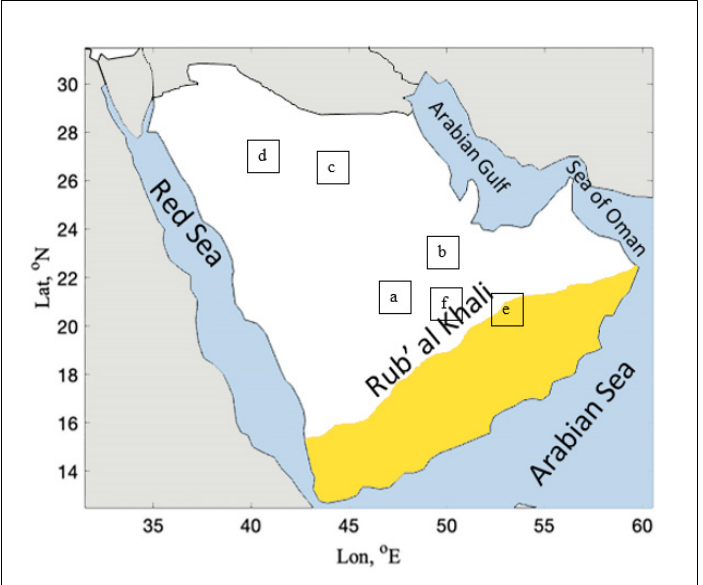
Figure 10. Locations with the highest solar irradiance in the Arabian Peninsula are highlighted in yellow. Points a–f represent locations used to check the efficiency of the machine learning ResNet model.